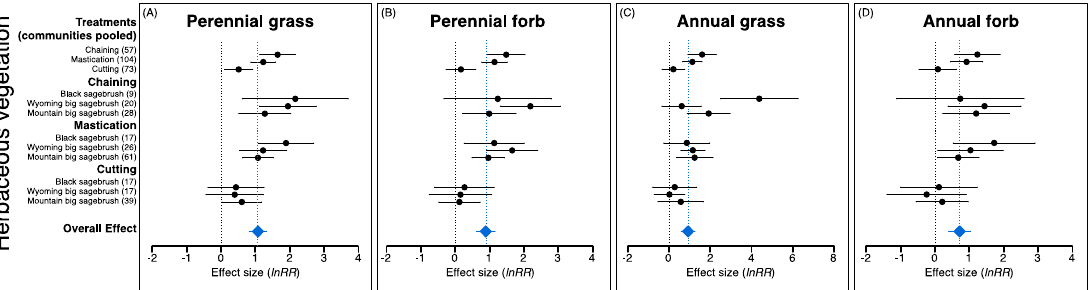
Figure 4. Mean effect sizes and 95% confidence intervals ( lnRR ; pre vs. posttreatment cover) for perennial grass ( A ), perennial forb ( B ), annual grass ( C ), and annual forb ( D ) vegetation responses following pinyon–juniper reduction in three sagebrush community types (i.e., black sagebrush ( Artemisia nova